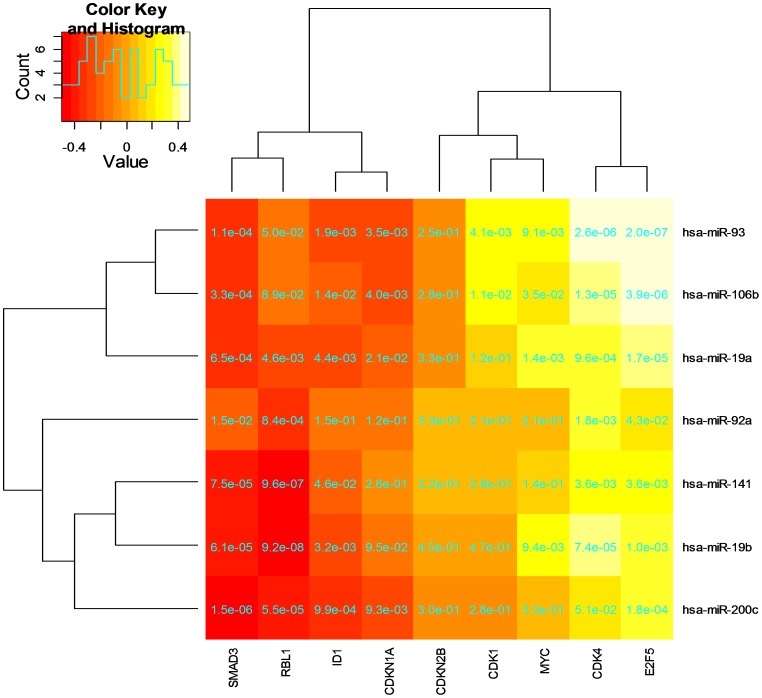
The transcriptional correlations of miRNAs in modules p-module-5-ne (ps) with TGF-beta signaling pathway downstream genes.The number presented on each cell is the p-value of the correlation for the corresponding miRNA and mRNA (gene).